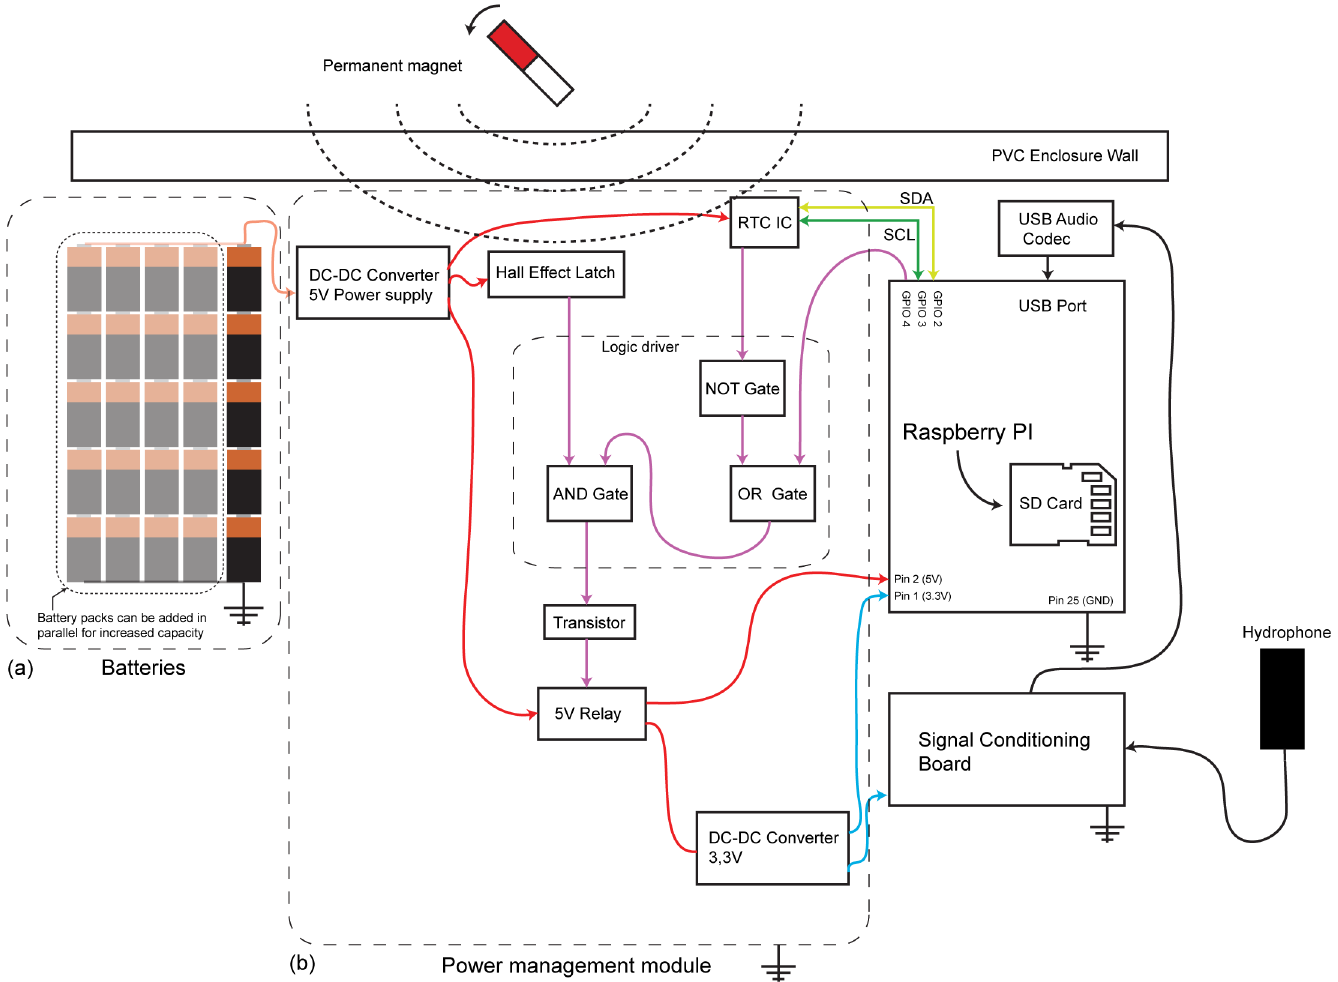
Fig 4. A schematic representation showing the connections made between the components of the underwater recording